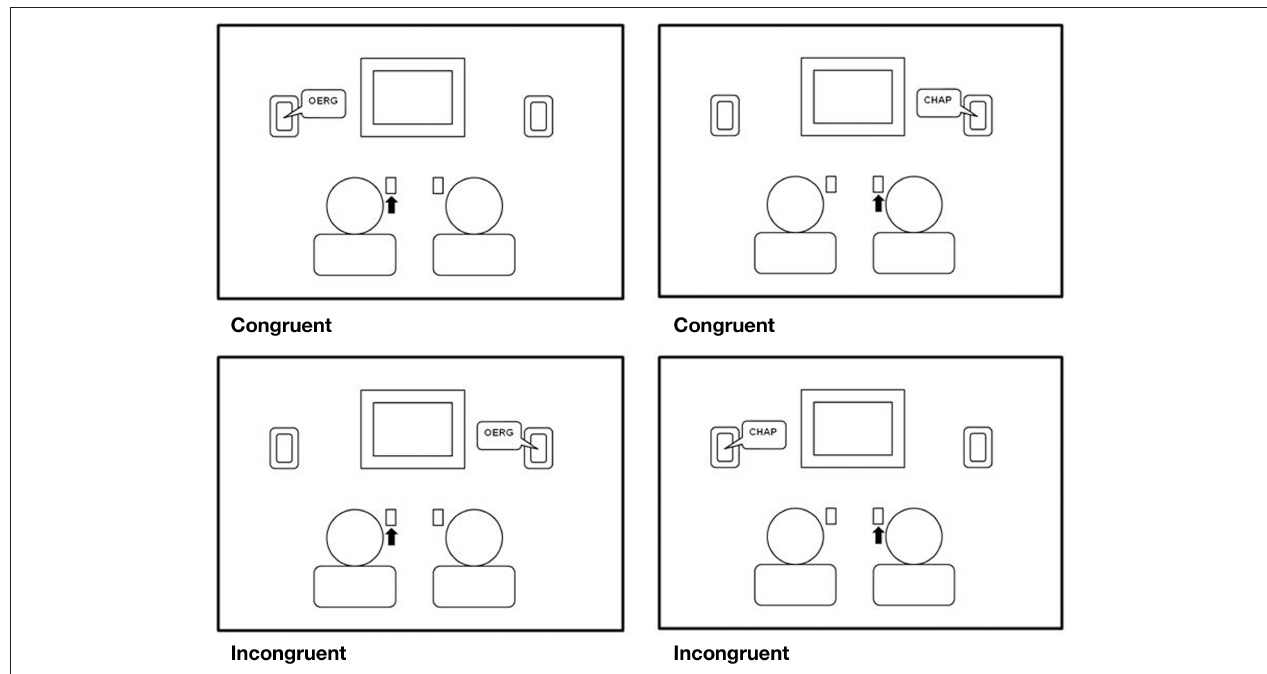
Figure 1 | Design of the social Simon task. The example shows a stimulus–location–congruent response (top panels) and an incongruent response (bottom panels) for the left and right located actor (left and right column, respectively).